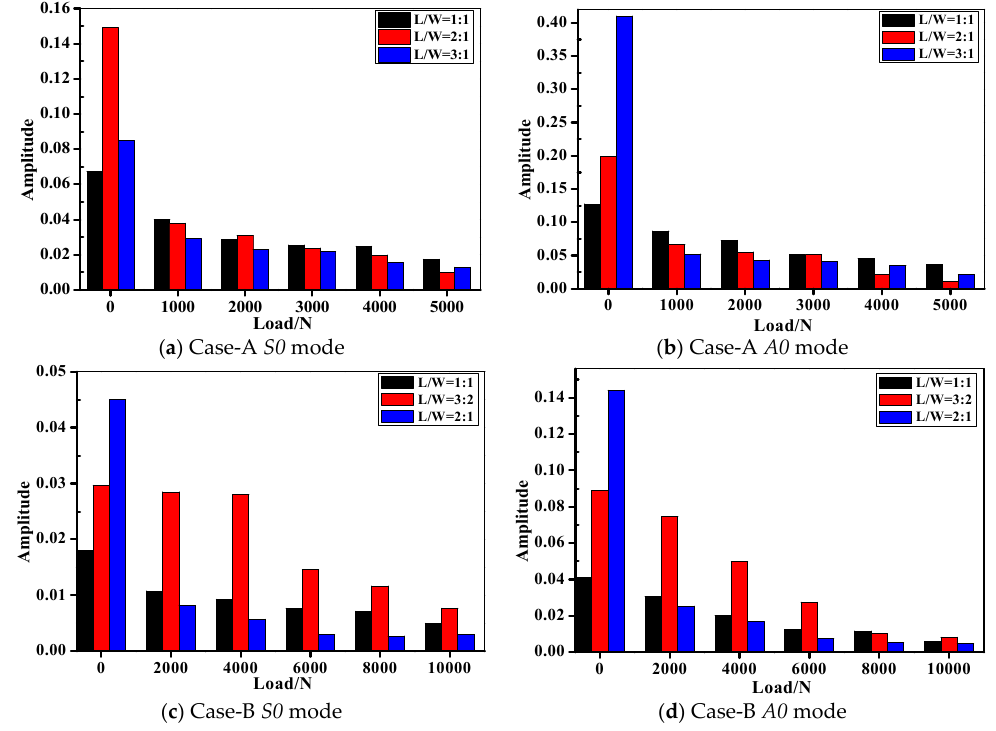
Figure 11. Comparison between amplitude of composite bolted joints during the tensile tests.